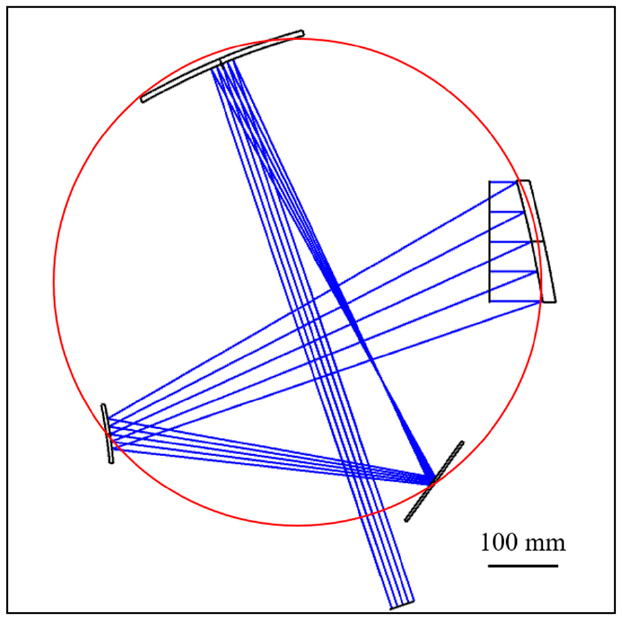
Figure 10. Initial structure layout of the off-axis four-mirror system.